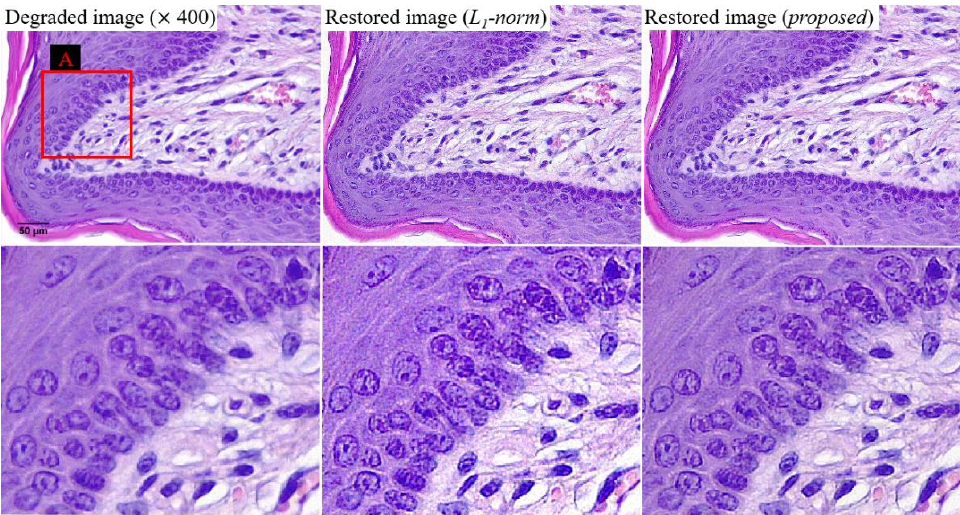
Figure 10. Examples of degraded image (magnification of 400), restored image ( l 1 -norm-based), and image restored using the proposed method.